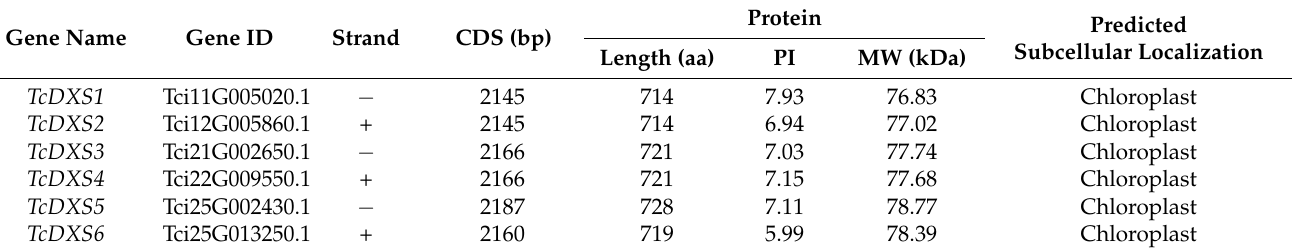
Table 1. Detailed characteristics of TcDXS genes of T. ciliata